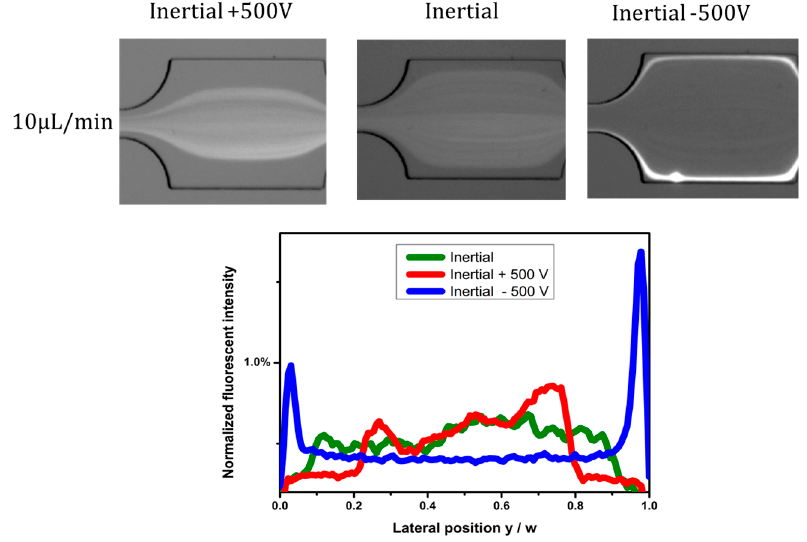
Figure 3. Effects of electric field direction.